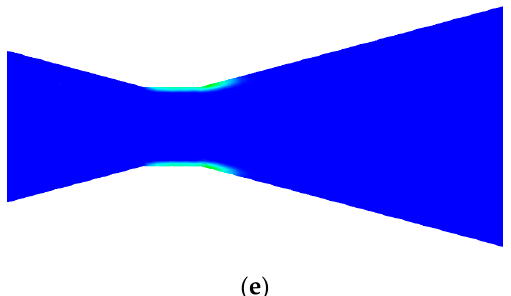
Figure 9. Contour of vapor volume fraction of the Venturi tube with different diffusion angles, ( a ) 10°, ( b ) 15°, ( c ) 20°, ( d ) 25°, ( e ) 30°.